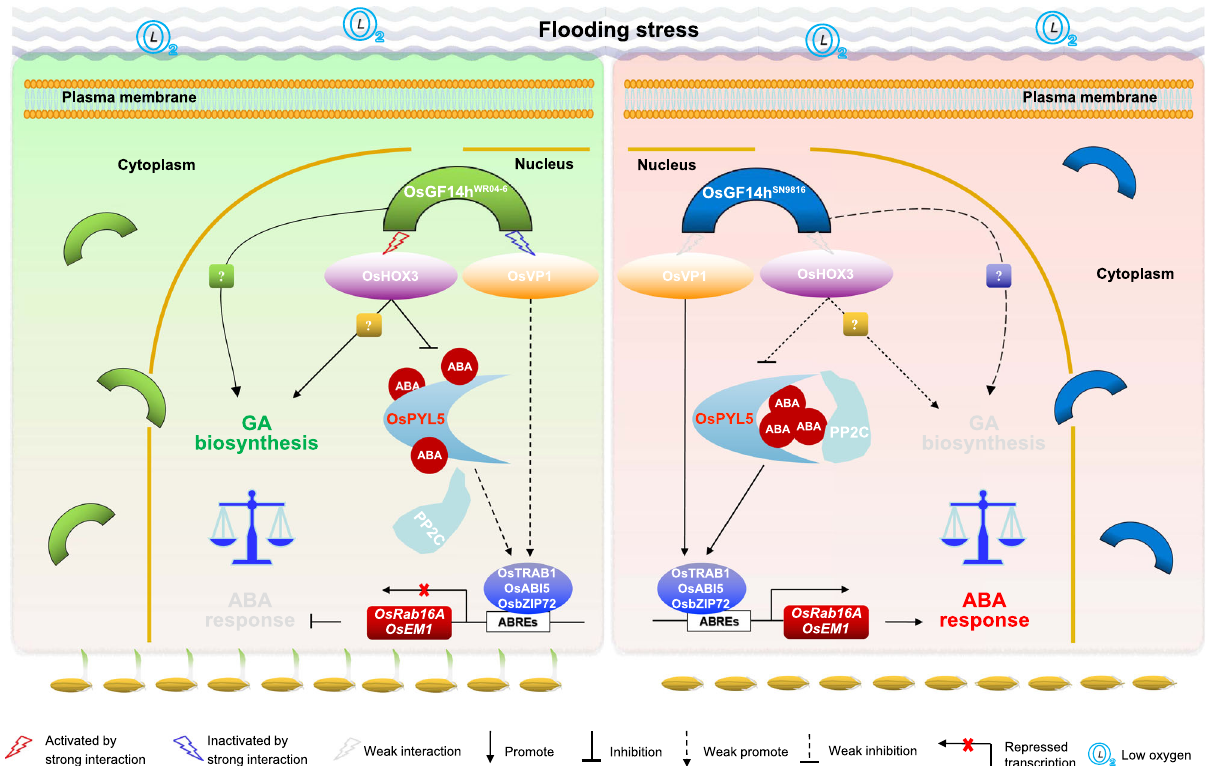
Fig.7|Proposedworkingmodelfortheregulationofanaerobicgerminationin rice by OsGF14h . A 14-3-3 protein, Os GF14h WR04-6 acts as an ABA signal switch that activates a transcription-repressor OsHOX3 and inhibits a transcription activator OsVP1bythestrong interaction.Onthe one hand,thedownstreamABA-regulation TFs and ABA-responsive genes Rab16A and OsEM1 are suppressed due to the ABA receptor OsPYL5 (a core positive regulator of the ABAsignaltransductionpathway in seed germination and early seedling growth) is inhibited by OsHOX3. On the other hand, ABA-responsive genes are also inhibited due to the functional